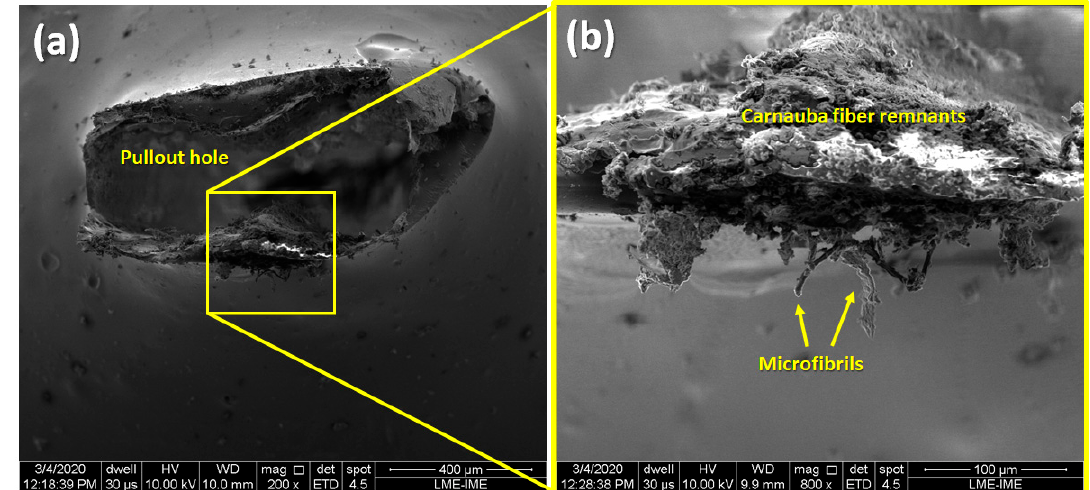
Figure 6. Specimens micrographs of pullout tests. ( a ) 200×, ( b ) 800×.